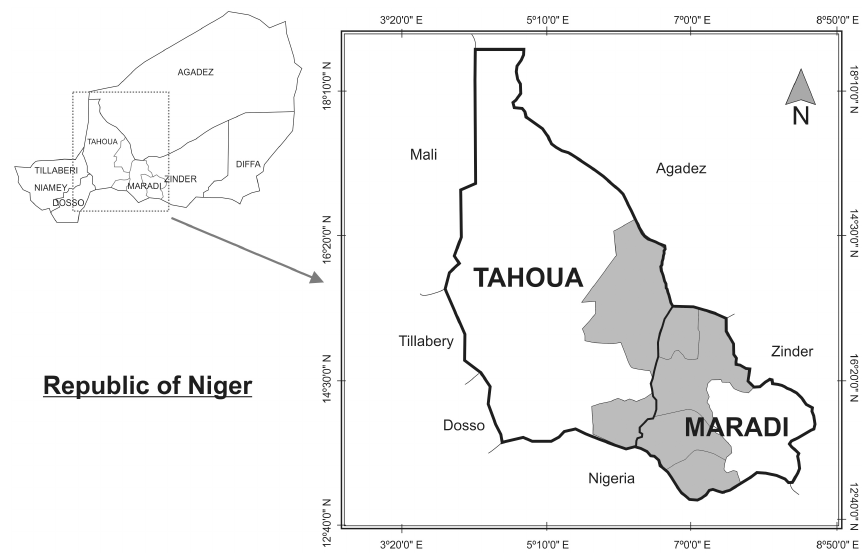
Figure 1. Map (own work of Iván Fernández and Maaouia A. Moussa) illustrating the limits of the provinces of Tahoua and Maradi in the Republic of Niger. Areas in which sampling was carried out are in light